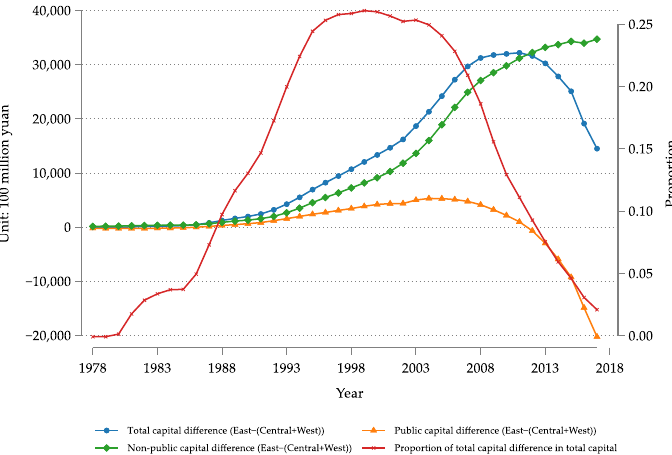
Figure 9. Capital differences (East − (Central + West)).